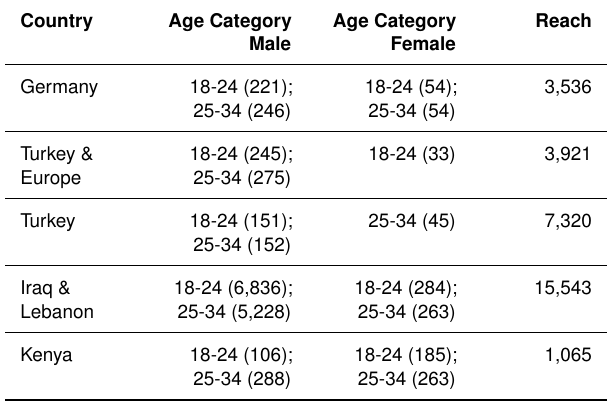
Table 3. Sample cemographic breakdown.